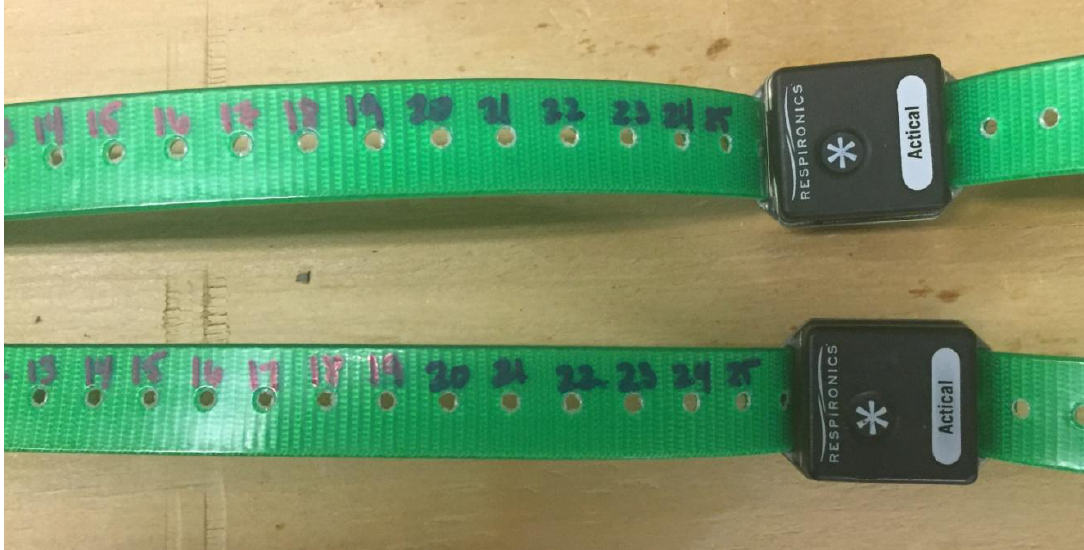
Figure 5. Demonstration of Actical accelerometer placement and determination of collar tightness. For P2, P3, and P4, one Actical accelerometer is placed per collar. For P2, both collars were placed with the same tightness. The buckle holes are numbered such that the collar can be loosened by four holes for P3 and P4, based on the buckle hole number used for tight fit for each dog. For example, if a dog had a tight fit of buckle hole 16, the loose fit was